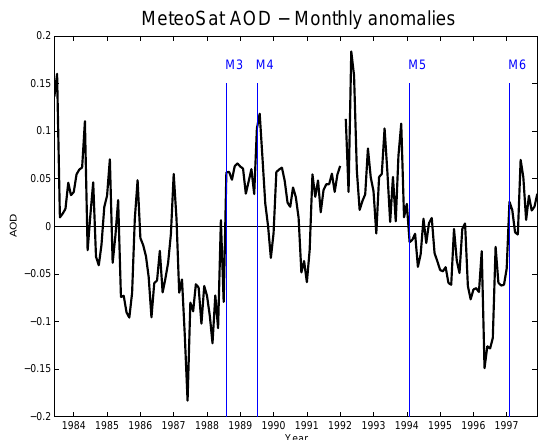
Fig. 14. Monthly AOD anomalies over the Mediterranean Sea retrieved by MVIRI sensors onboard Meteosat-2 to -6. Blue lines indicate platform changes.